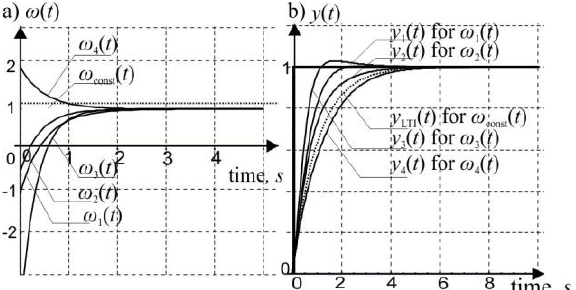
Fig. 3. LTV filter (a) parametric functions, (b) step responses.